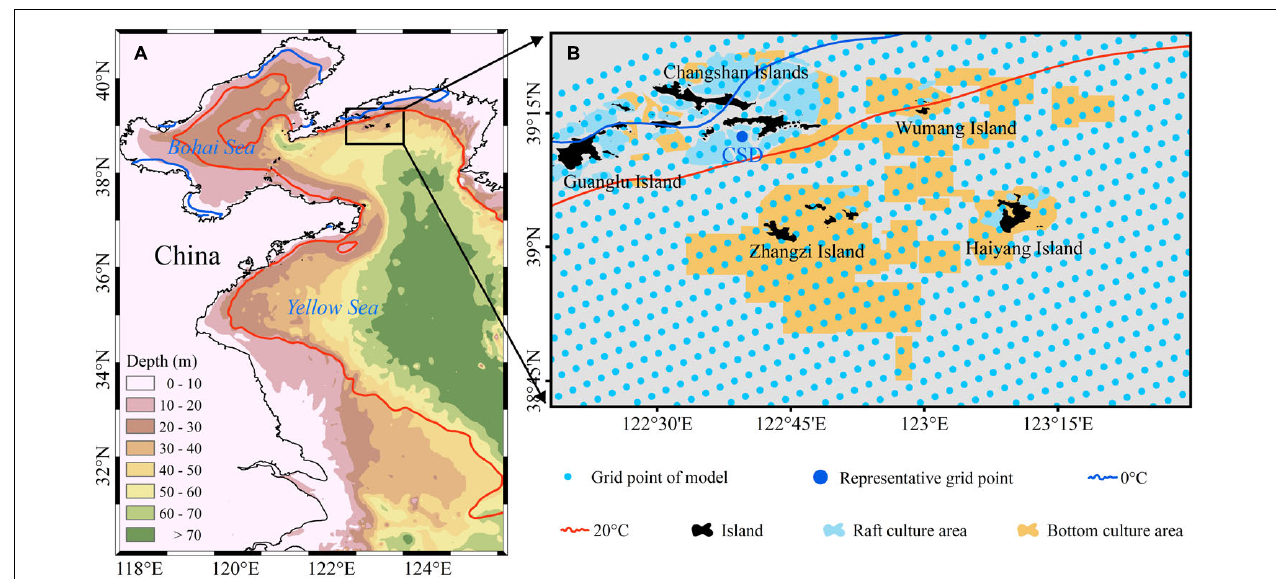
FIGURE 1 | Topography (background) and study area, Changhai sea, China (black box) (A) . Status quo of sea use with traditional raft culture areas (blue polygons) and bottom-culture areas (yellow polygons). The representative grid point CSD (blue point) was chosen from grid points of the YeSCE model (light blue point) for dividing the growth process under different match-mismatch conditions. The contour lines represent a multiyear average temperature of 0 ◦ C isotherm on February 1 (blue solid line) and 20 ◦ C isotherm on September 1 (red solid line) (B)